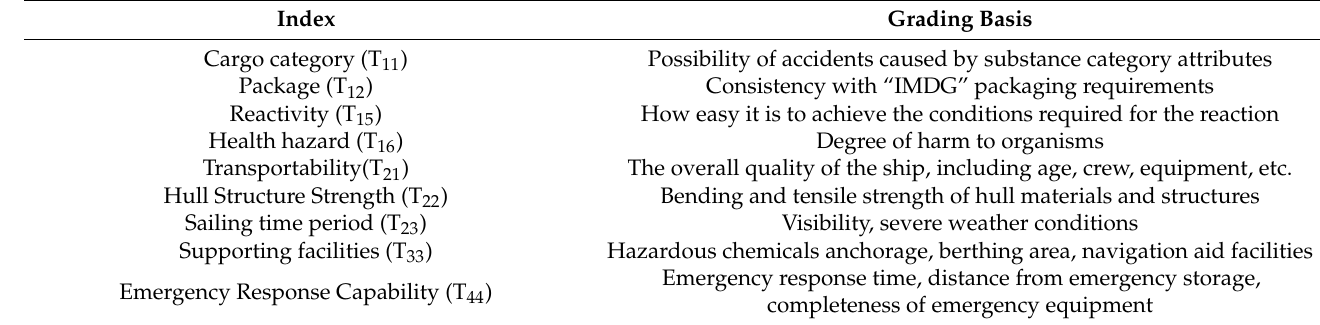
Table 4. Qualitative index grading basis.